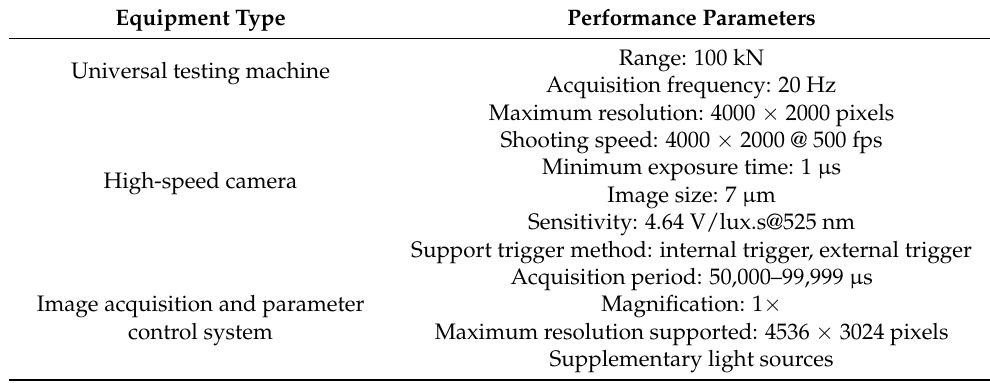
Table 2. Equipment types and performance parameters.